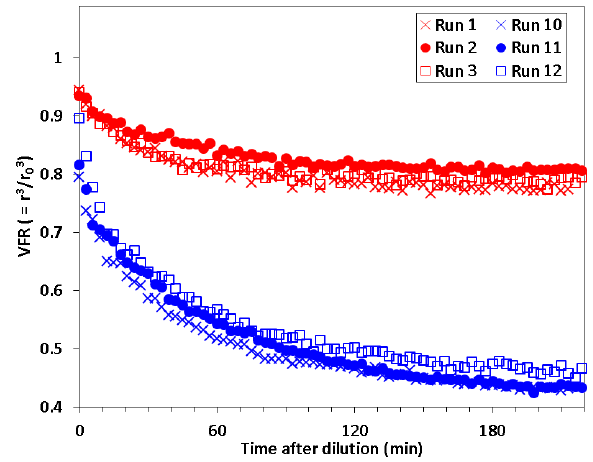
Figure 5. Time series of volume fraction remaining (VFR) mea- sured for SOA particles after dilution under dry (RH < 1%; runs 1, 2, and 3) and humid conditions (RH ≈ 40%; runs 10, 11, and 12).